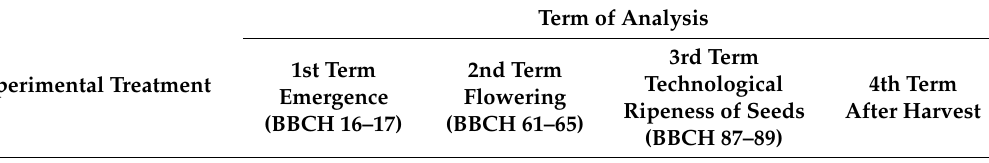
Table 5. The count of